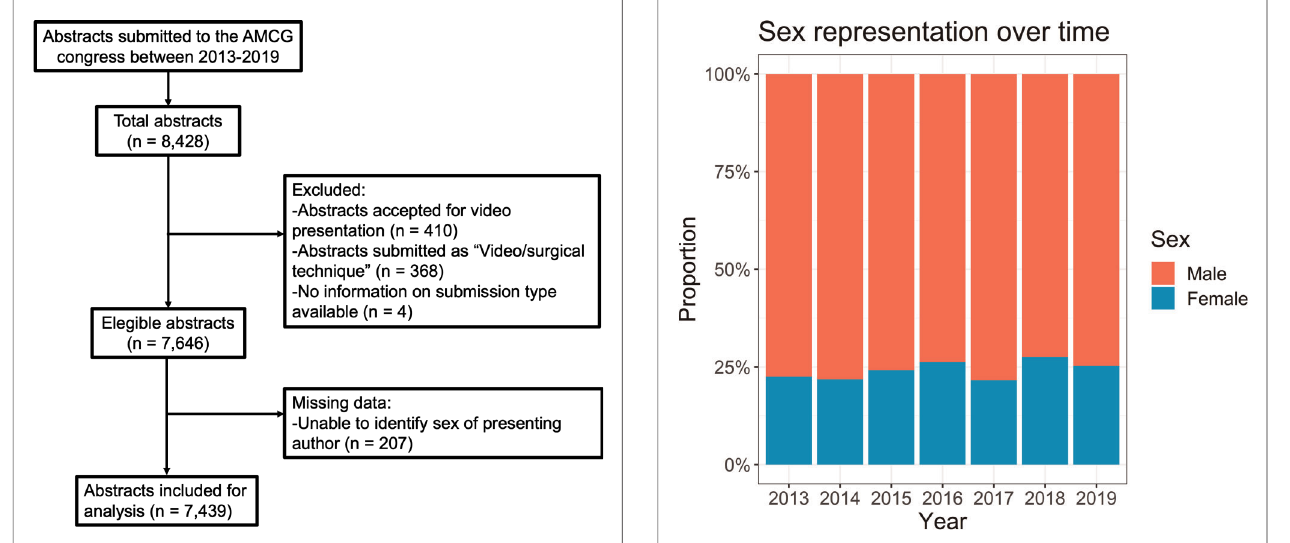
FIGURE 1 | Flow diagram showing data obtained for this study. FIGURE 2 | Abstracts submitted to AMCG annual meetings from 2013 to 2019 compared by sex. The year with the highest proportion of accepted abstracts from females was 2018, while 2017 showed the lowest